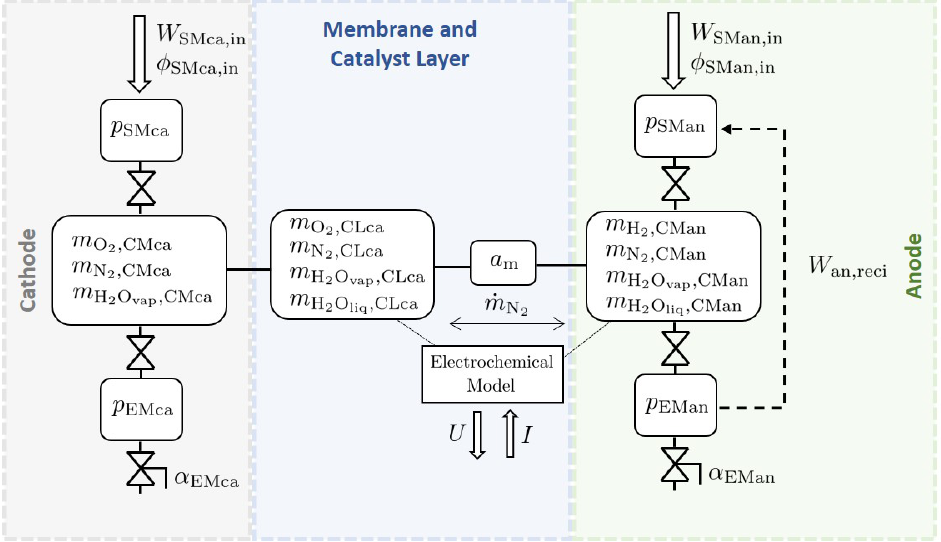
Figure 2. Lumped model structure of the dynamic fuel cell stack